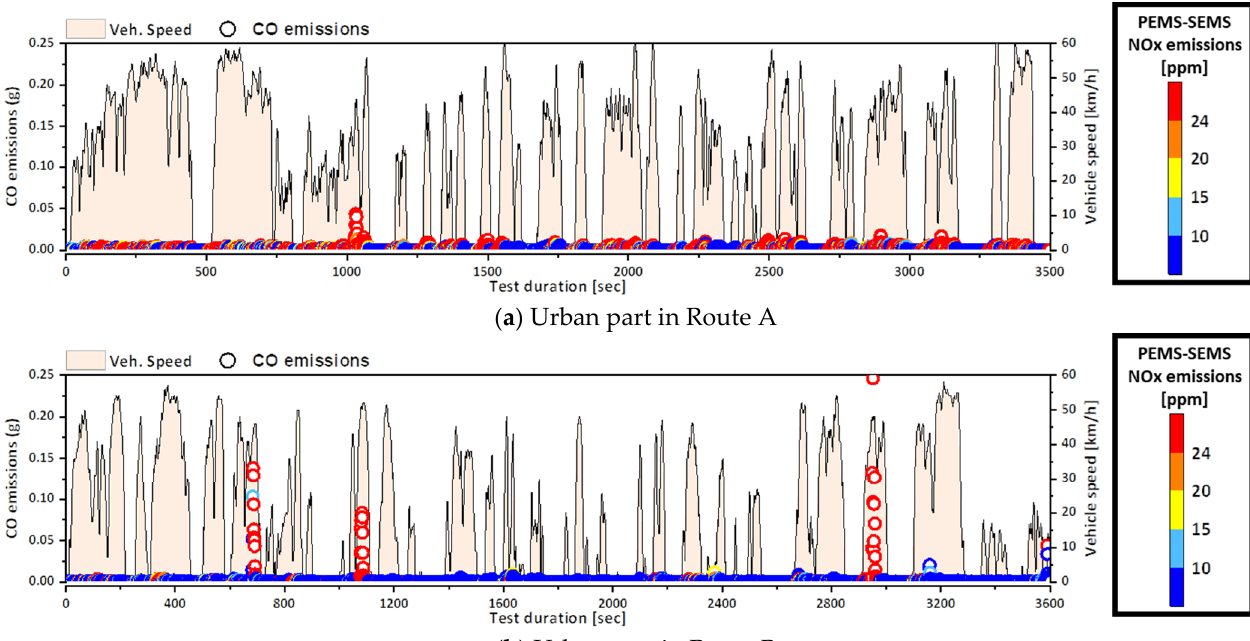
Figure 20. Real-time profiles of CO emissions and the difference between NOx emissions measured by the PEMS and SEMS equipment under urban part in Routes A and B.